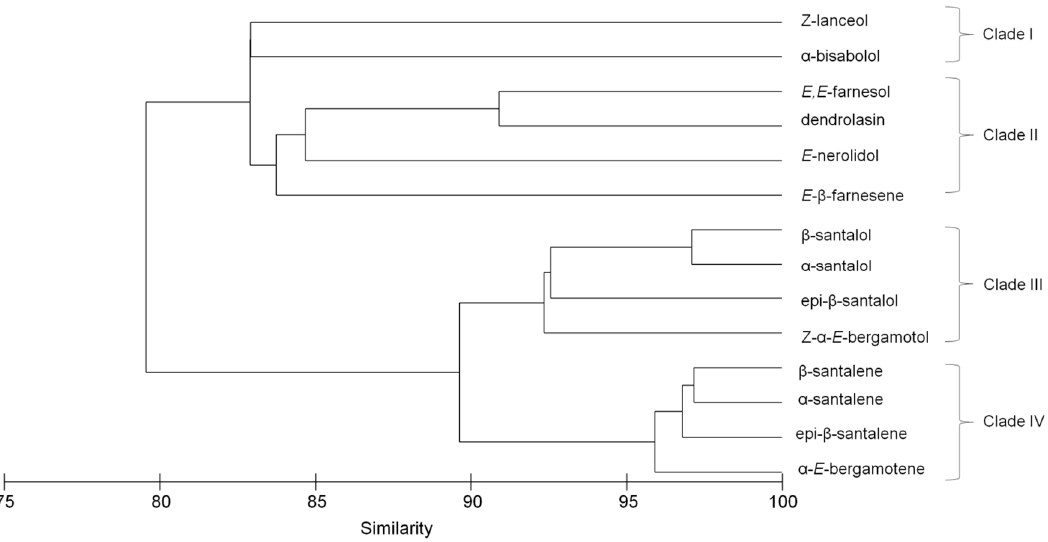
Figure 5. Dendrogram showing co-occurrence patterns of 13 major components using hierarchical cluster analysis from the heartwood extract samples of 194 S. spicatum individuals distributed in Western Australia: 152 trees from the south-west (Wheatbelt), 19 trees from the south-east (Goldfields) and 23 trees from the north regions (Carnarvon and Shark Bay).